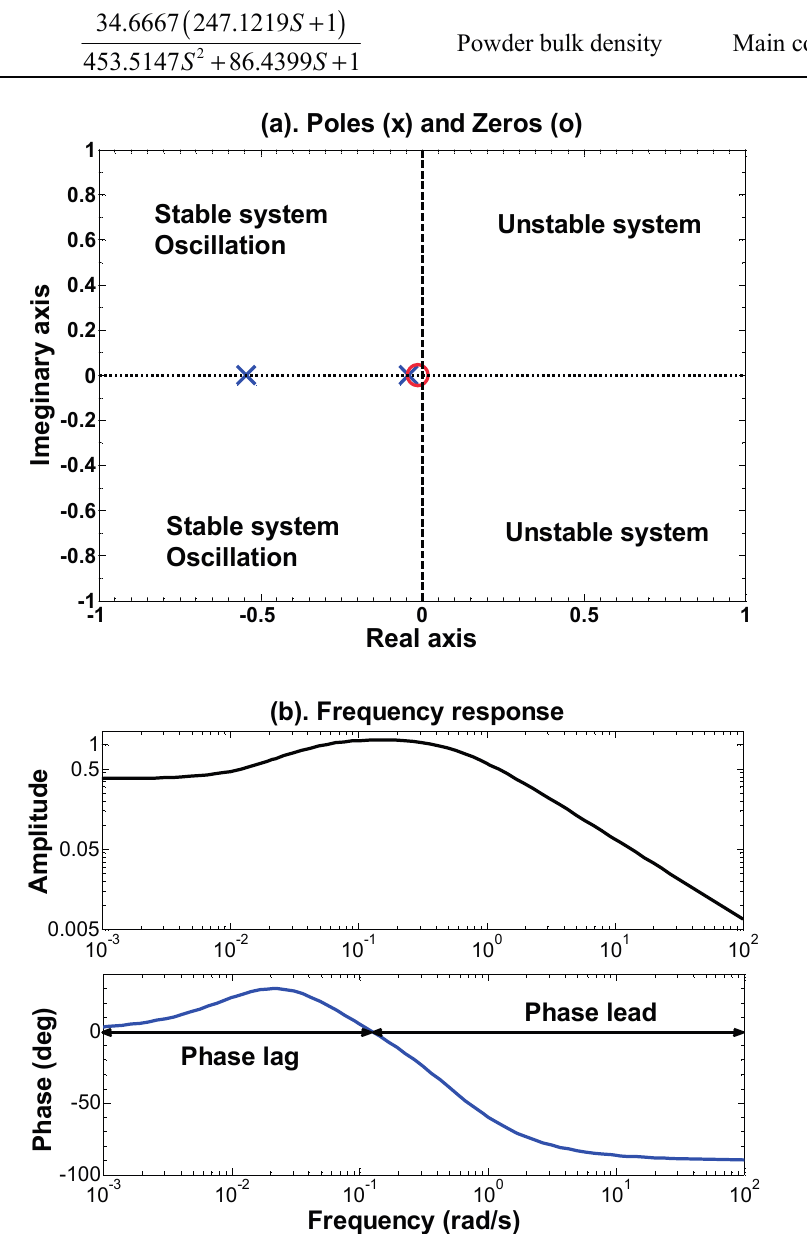
Figure 1. Poles-zeros plot and phase diagram of transfer function model relating fill depth with main compression force. ( a ) Poles-zeros plot; ( b ) Frequency